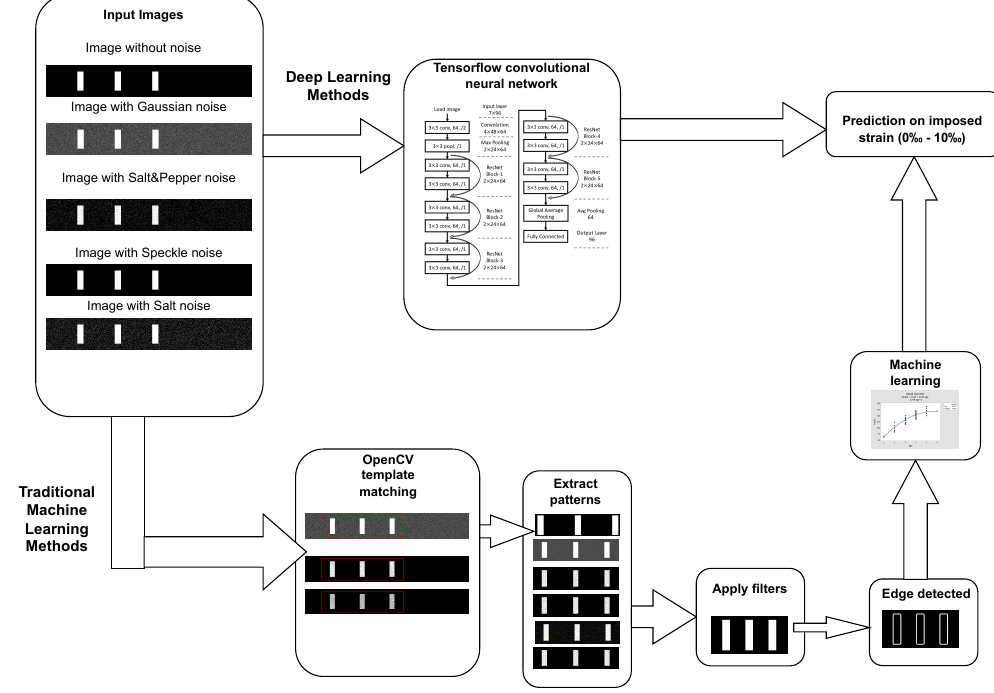
Figure 6. Illustration of the overall